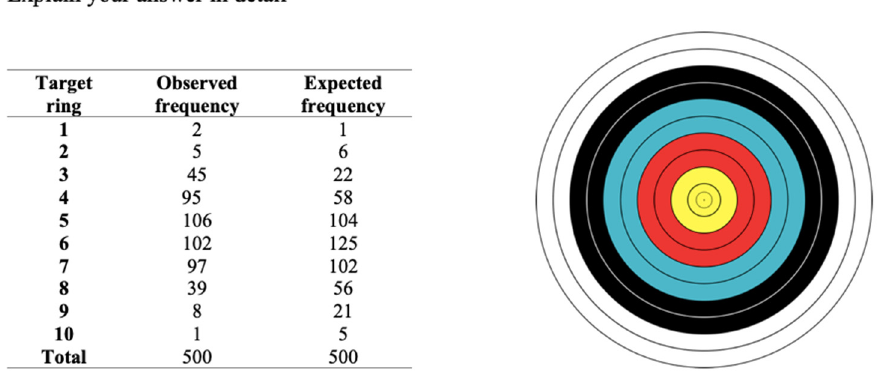
Figure A3. Activity/Problem 1 (Retrieved from [37]).